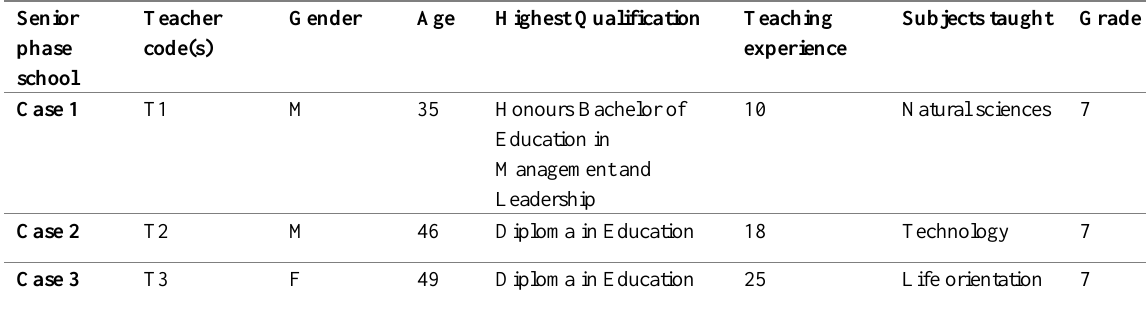
Table 1: Demographic Information of